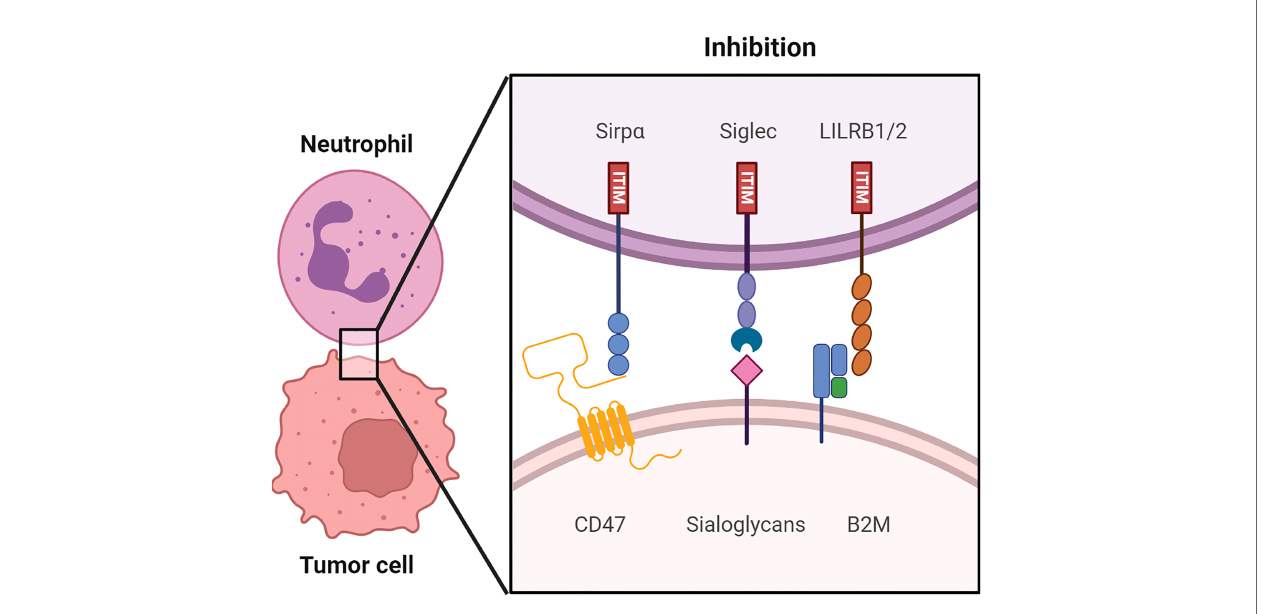
FIGURE 1 | An overview of putative immune checkpoints molecules regulating myeloid cell function in human tumor microenvironments (TME). Receptor-ligand interaction including the CD47-SIRP a axis, sialoglycans-Siglec axis and HLA1 (B2M)-LILRB 1/2 axis in the immune synapse between the myeloid cells, such as neutrophils and macrophages and the tumor cells. Src family kinases phosphorylate the ITIM upon binding of checkpoint molecules to their respective receptors. The following recruitment and activation of SHP-1 and SHP-2 suppresses the anti-tumor immune responses. Consequently, tumor cells are able to evade immune